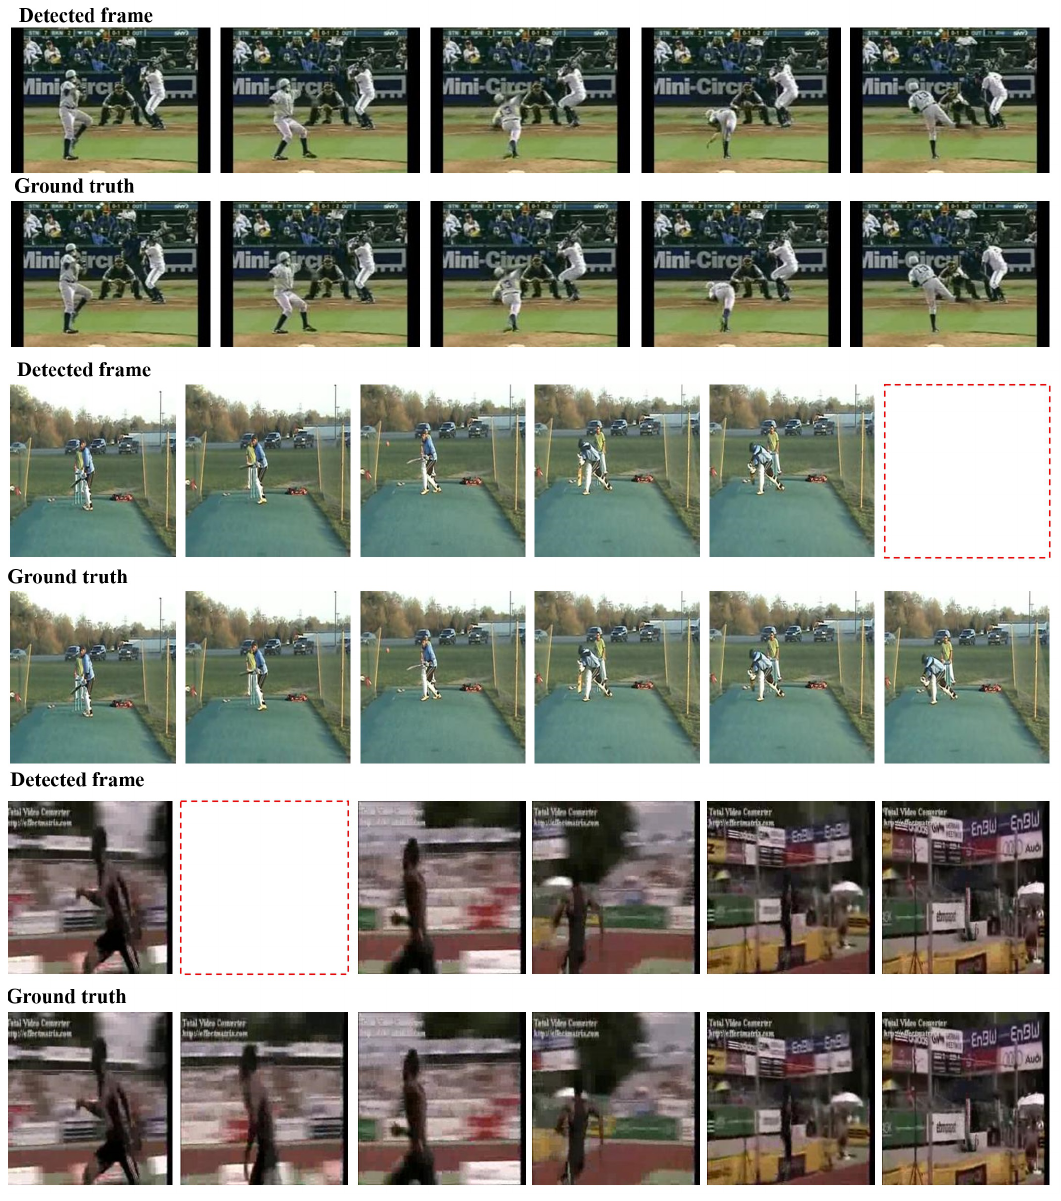
Figure 5. Examples of key frames detected along with the automatically annotated ground truth. Note that the empty red box denotes a missing key frame in the detected frames which implies that our method has detected more key frames than the automatically annotated ground truth. It can be observed that the key frame detected by our method are very similar to the ground truth. (best seen in